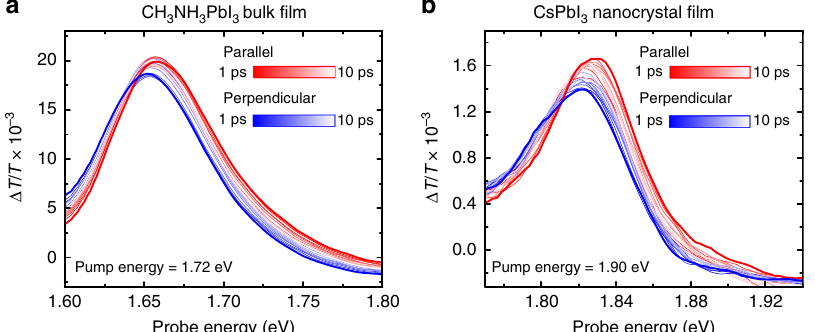
Fig. 3 Spectrally resolved picosecond transient absorption spectra. a CH 3 NH 3 PbI 3 hybrid perovskite bulk fi lm (excitation approximately 1.72 eV, 15 µ Jcm − 2 ) and b CsPbI 3 nanocrystal fi lm (excitation approximately 1.90 eV, 4 µ J cm − 2 ). The samples were excited with laser pulses of FWHM approximately 25meV and pulse length of approximately 50fs. The change in transmission of the probe was measured at the indicated time delays with the linear polarization of the probe pulse aligned parallel (red) or perpendicular (blue) to the linear polarization of the pump pulse. The initially polarization-dependent spectra converge within the fi rst 10ps after